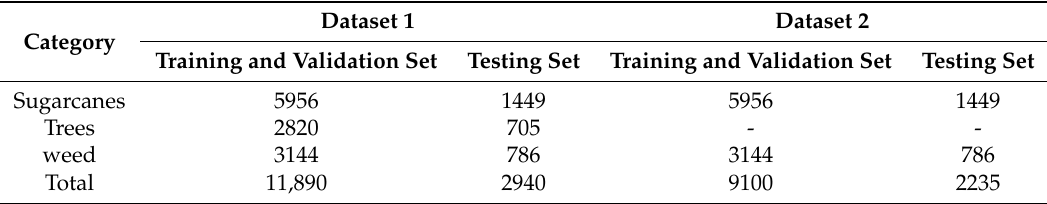
Table 2. The dataset used for feature extraction and training the model.